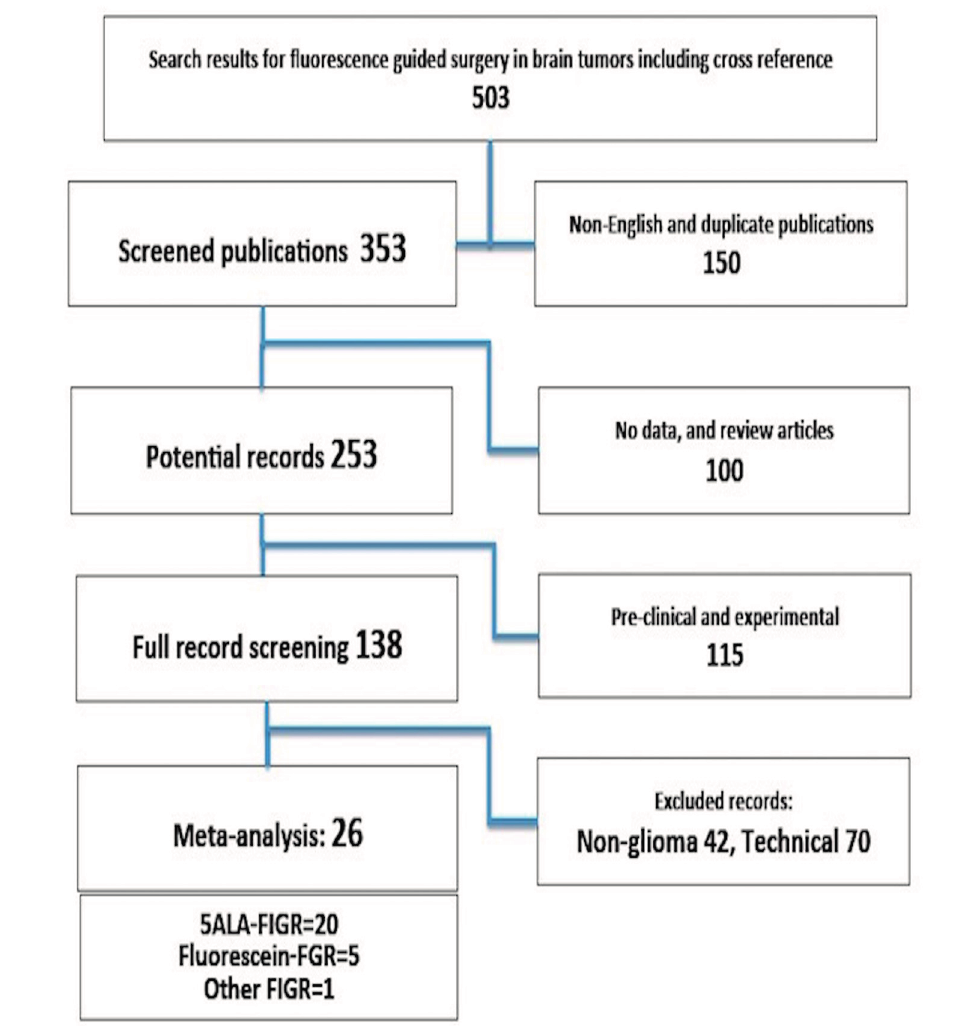
Figure 1. Details of the literature